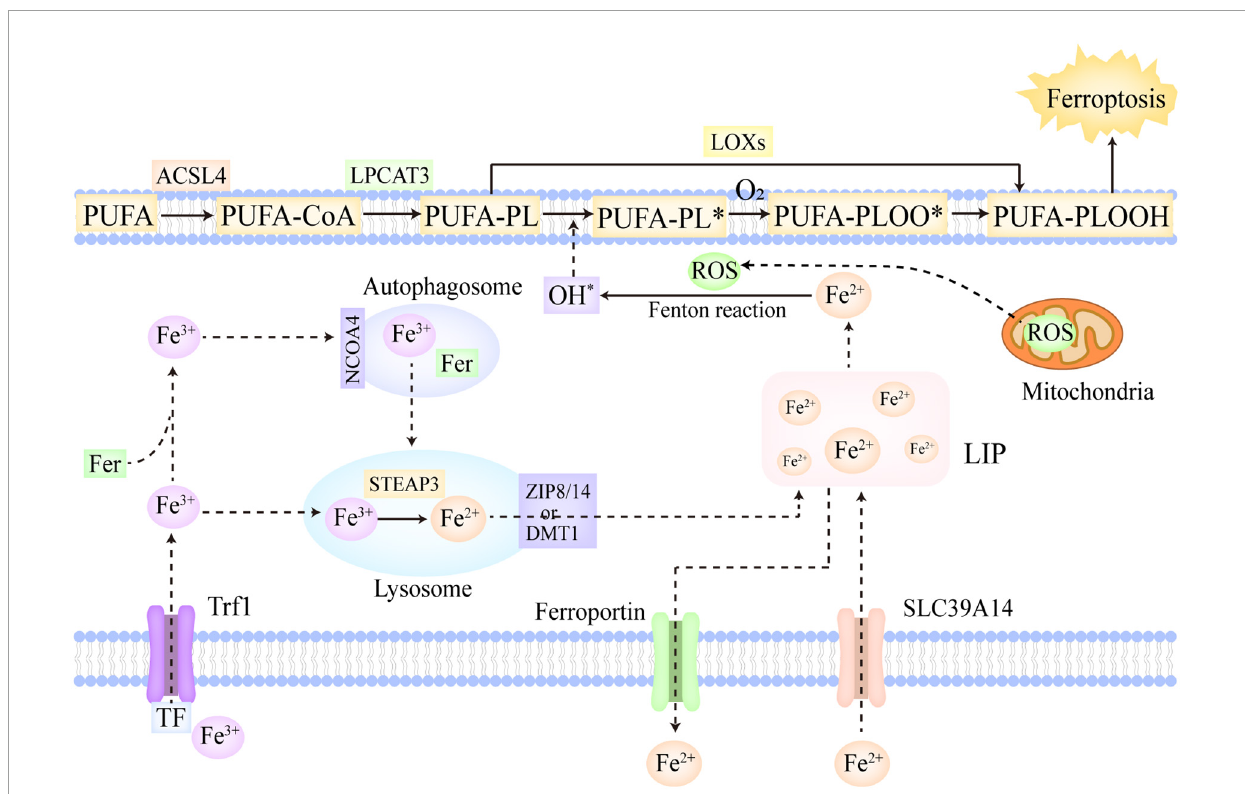
FIGURE1 The molecular mechanisms of ferroptosis. Fe 3 + is the predominant form of iron in circulation, which often combines with Trf and can be imported into cells via Trf1 located on cellular membrane. In addition, a part of iron can be imported into cells by SLC39A14 in the form of Fe 2 + . The Fe 3 + within cells is firstly reduced to Fe 2 + in the lysosome catalyzed by STEAP3, and then, ZIP 8/14 or DMT1 leads to the release of Fe 2 + from the lysosome into LIP. Moreover, the Fe 3 + in cells can also be stored in ferritin. NCOA4 can recognize ferritin and mediate ferritinophagy, reducing stored Fe 3 + to Fe 2 + and ultimately releasing Fe 2 + into LIP. Furthermore, ferroportin is mainly in charge of the export of Fe 2 + from cells. If the iron metabolism is disrupted, excessive Fe 2 + will trigger lipid peroxidation and ferroptosis. PUFAs, as the most predominant substrates of lipid peroxidation, are firstly converted to PUFA-PLs by ACSL4 and LPCAT3. In the enzymatic pathway, LOXs oxidize PUFA-PLs to PUFA-PLOOH. In the non-enzymatic pathway, the excessive Fe 2 + firstly reacts with ROS to generate OH • via Fenton reaction, which then abstracts hydrogen